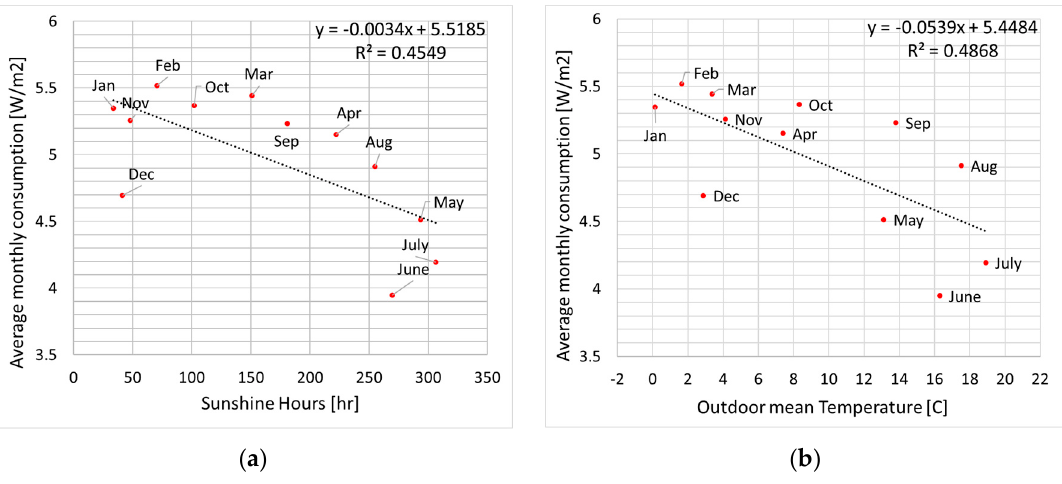
Figure 13. Average monthly consumption vs. measured ( a ) sunshine hours; ( b ) outdoor mean temperature.